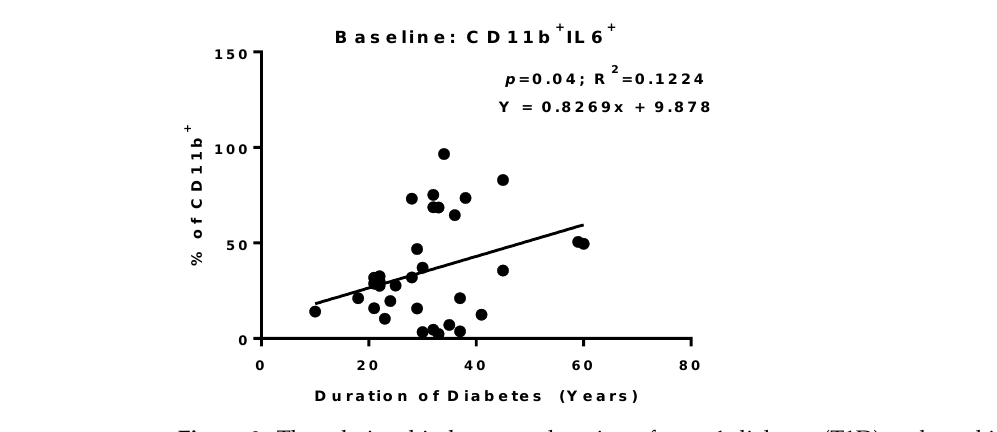
Figure 3. The relationship between duration of type-1 diabetes (T1D) and cytokine expression of PBMCs of DR patients. Correlation of T1D duration against percentages of CD11b + IL-6 + PBMCs in non-stimulated condition. Regression line, significance levels ( p ), coefficient of determination (R 2 ) and regression equation ( y = a + bx ) are shown on each graph. n = 41. Linear regression.